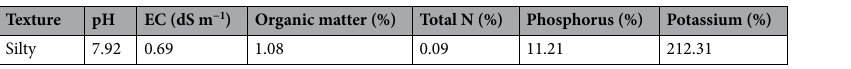
Table 2. Soil chemical